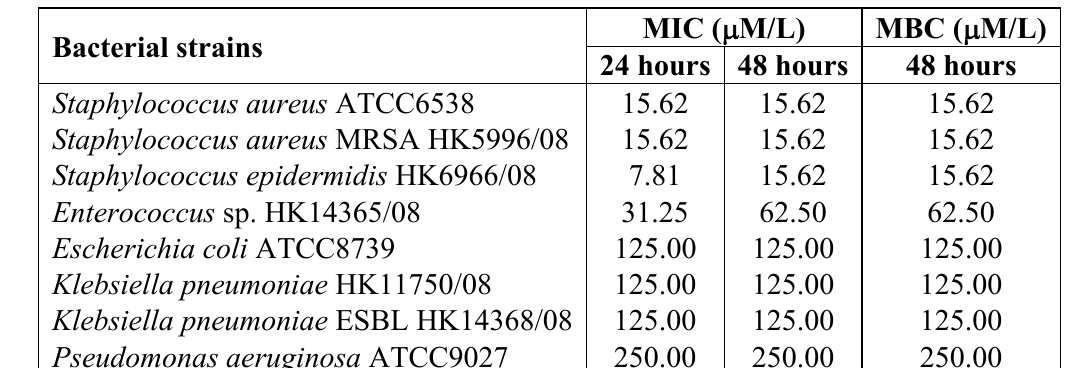
Table 2. In vitro antibacterial activity of compound 5 .